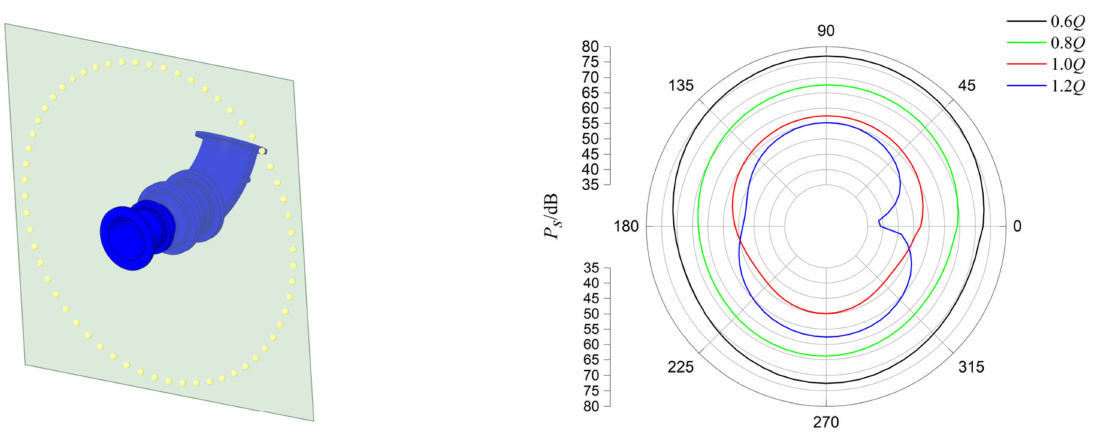
Figure 16. Schematic diagram of monitoring points and radiation noise directivity under different flow rate